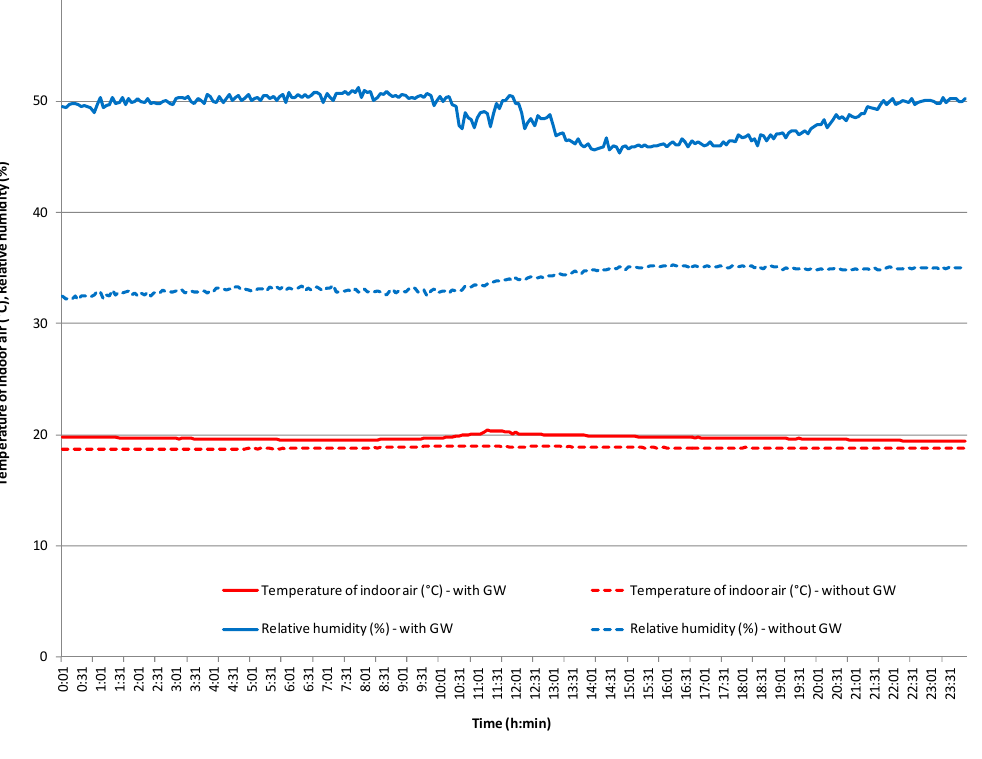
Figure 8. Comparison of air temperature and humidity between PK10 and PK